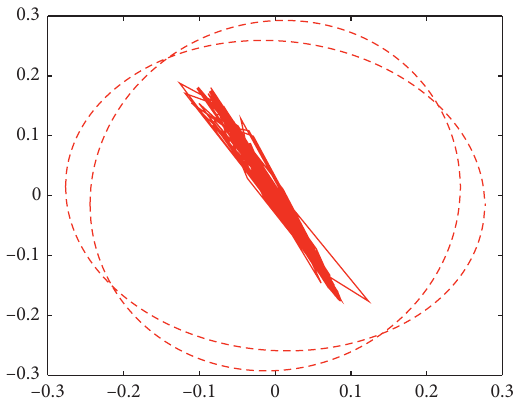
Figure 6: The ellipsoidal bound I and state trajectory of system (72) for Case 2.